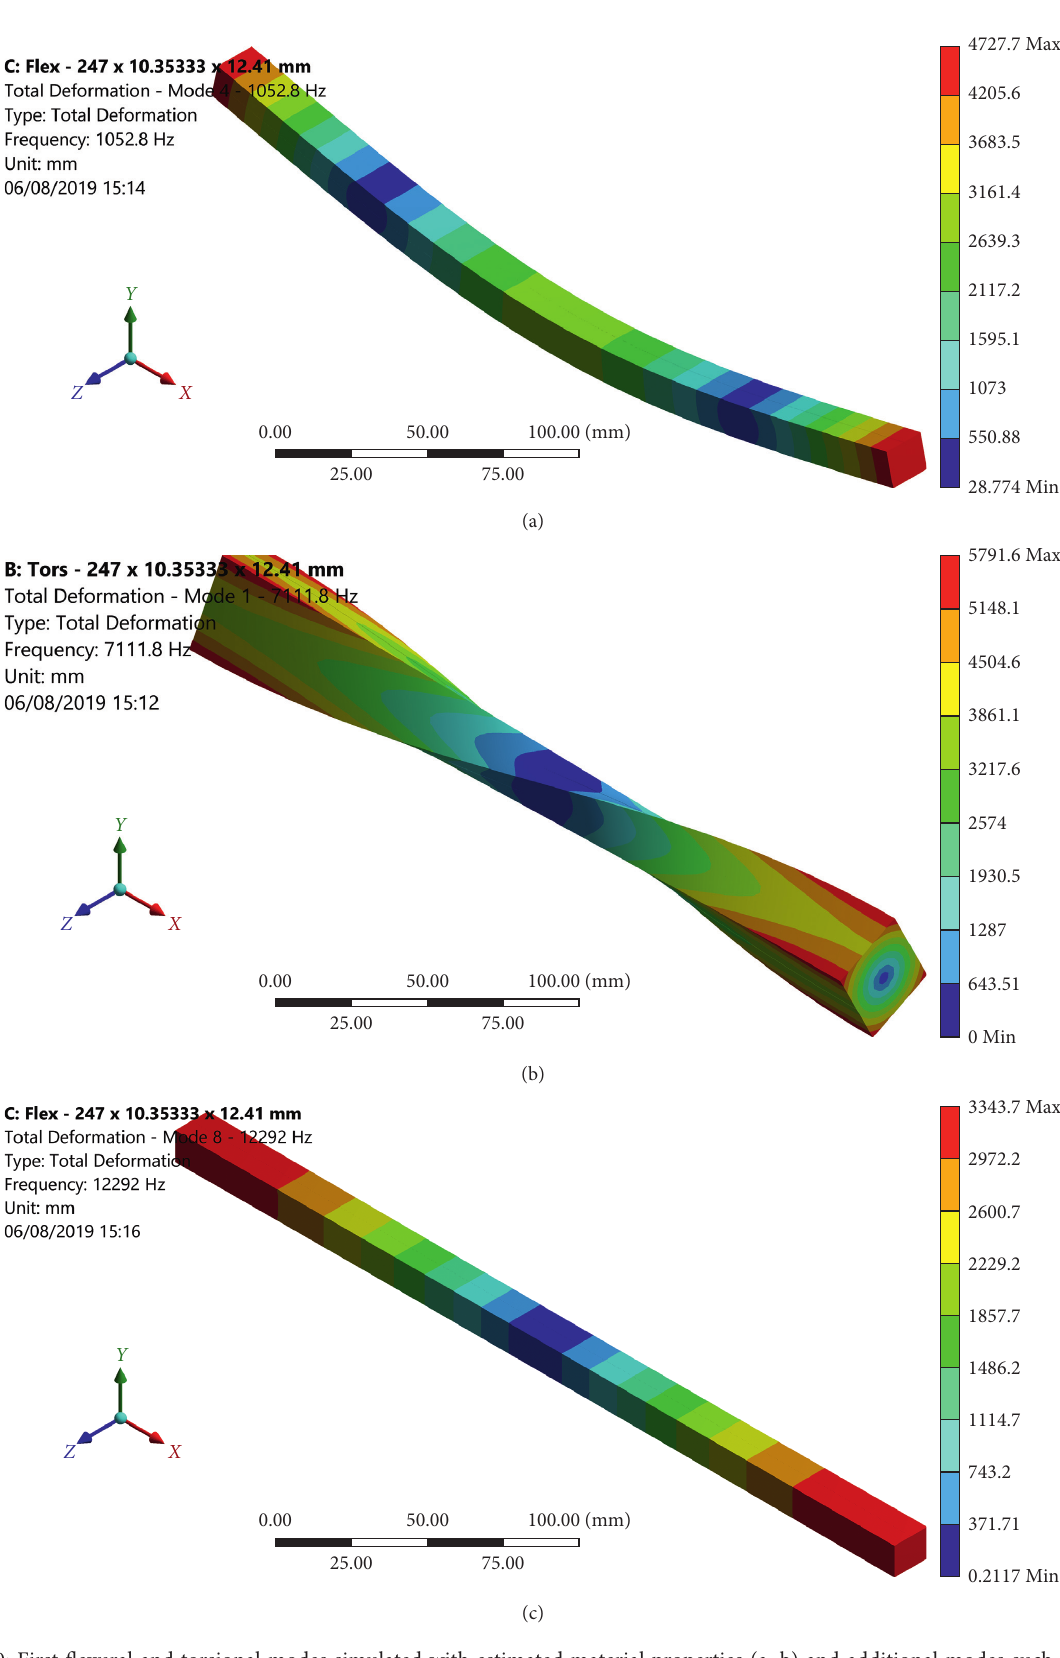
Figure 10: First flexural and torsional modes simulated with estimated material properties (a, b) and additional modes such as the first longitudinal one